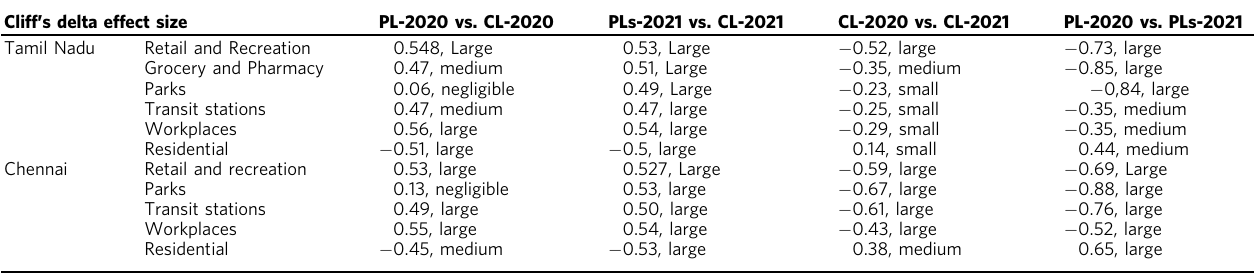
Table 3 Effect size for various group comparisons between various phases of lockdown in waves one and two in Tamil Nadu State and Chennai